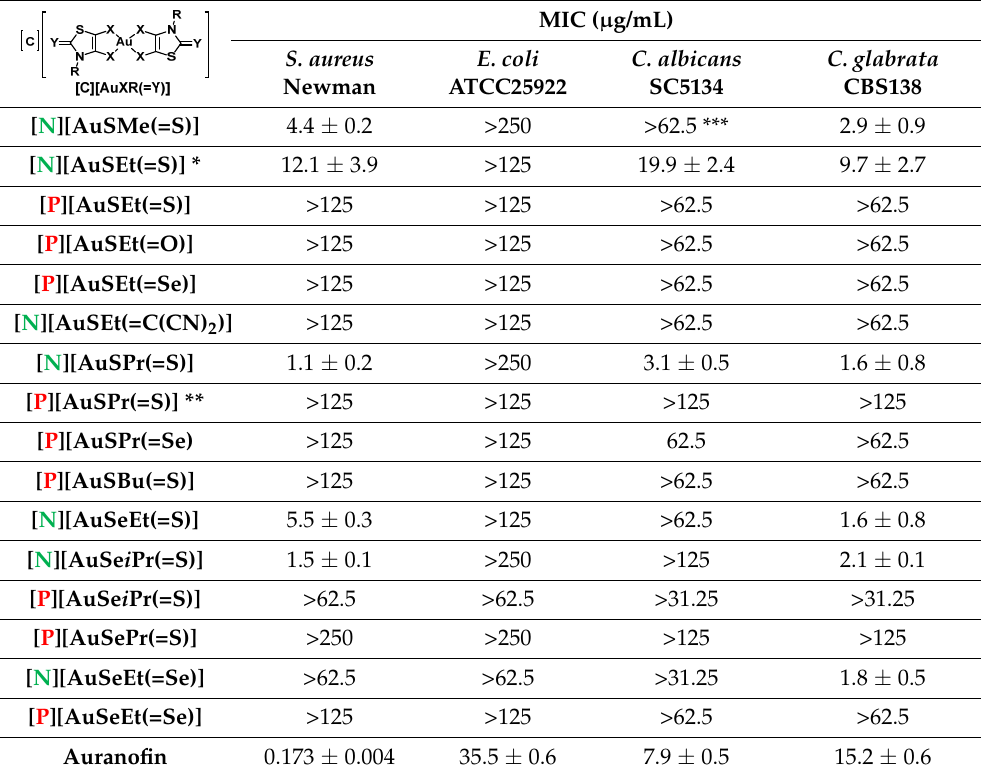
Table 4. MIC values (in µg/mL) of the complexes under study against the representative Gram- positive S. aureus , the Gram-negative representative E. coli and the Candida species C. albicans and C. glabrata . MIC values below 10 µg/mL are boxed in bold.